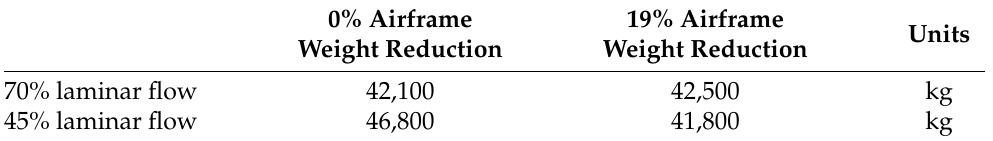
Table 13. MTOM values for the limit load factor of